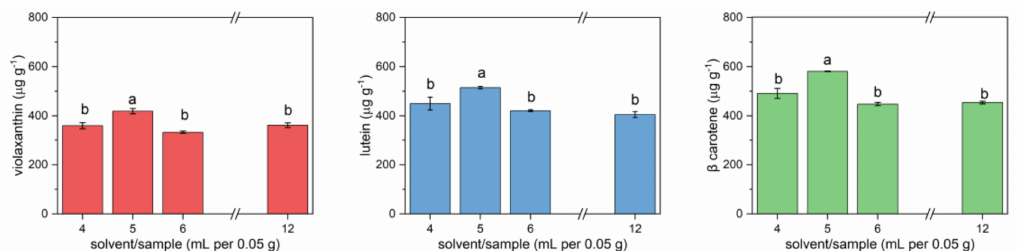
Figure 2. Carotenoids extracted from lettuce microgreens with di ff erent solvent / sample ratios. Error bars indicate standard deviation. Di ff erent letters mean a significant di ff erence at p < 0.05.